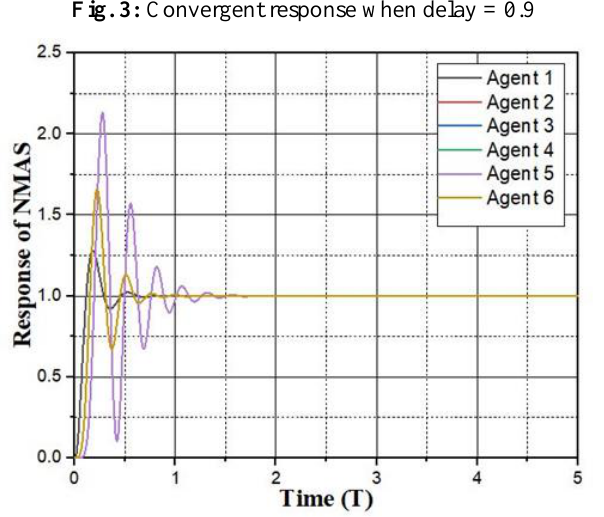
Fig. 3: Convergent response when delay = 0.9